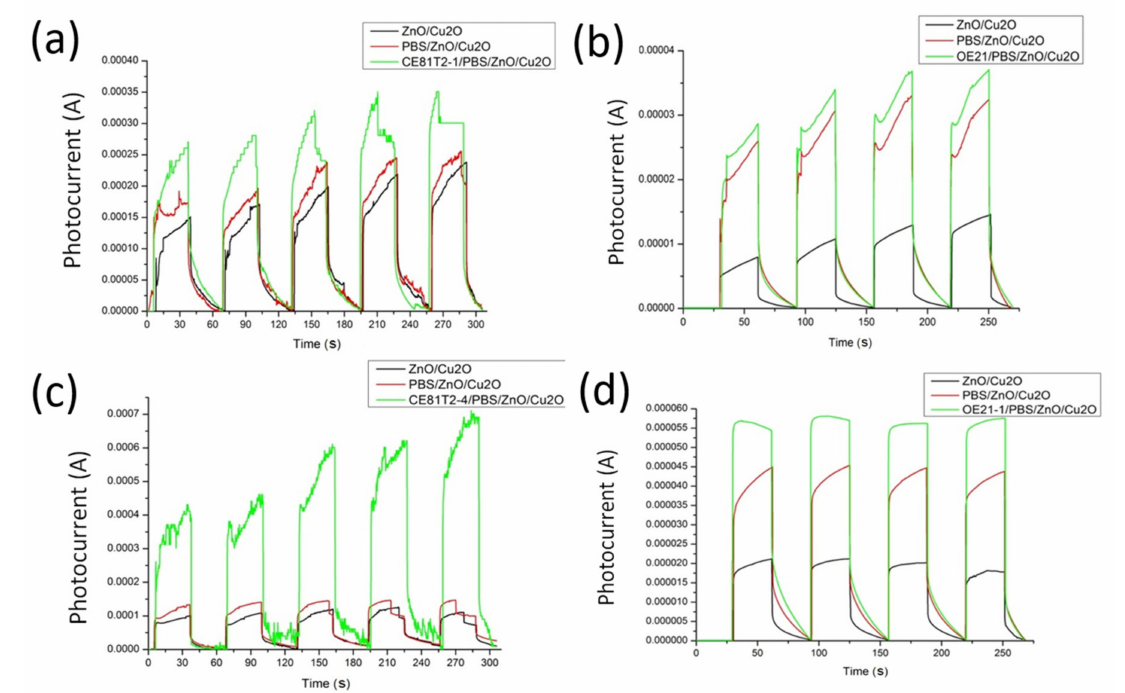
Figure 8. Photoelectrochemical response of esophageal squamous cell carcinoma by N-type element. ( a ) Comparison of light response analysis between blank biochip and adding PBS and PBS/CT81T2-1, respectively; ( b ) light response of empty biochip with PBS and PBS/OE21; ( c ) light response of empty biochip with PBS and PBS/CT81T2-4; ( d ) empty biochip with PBS and PBS/OE21- 1 light